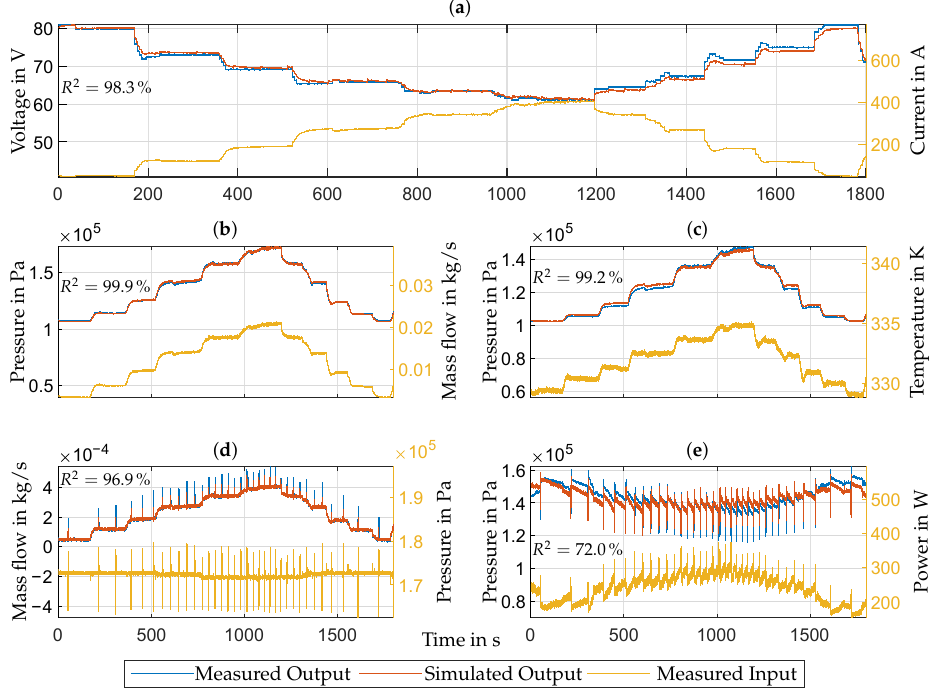
Figure 3. Model inputs and outputs. Plot ( a ): stack voltage U (blue and red) and stack current I (yellow). Plot ( b ): cathode supply manifold pressure p ca,sm (blue and red) and incoming cathode mass flow ˙ m ca,in (yellow). Plot ( c ): cathode exit manifold pressure p ca,em (blue and red) and FC temperature T (yellow). Plot ( d ): incoming anode mass flow ˙ m an,in (blue and red) and anode supply manifold pressure p an,sm (yellow). Plot ( e ): anode exit manifold pressure p an,em (blue and red) and anode recirculation pump power P an,reci (yellow).